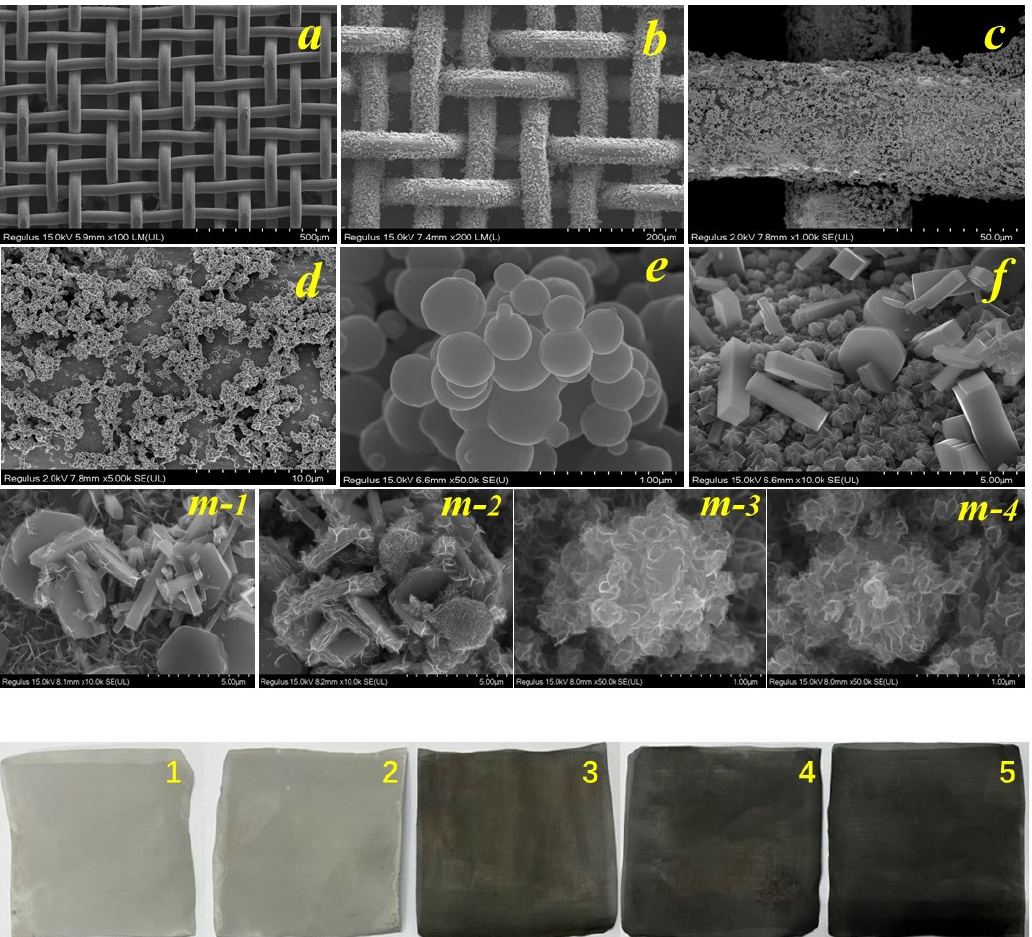
Figure 2. SEM of the samples. TiO 2 electron microscope pictures with different magnifications ( a – e ); as-prepared cubic CaTiO 3 ( f ); figures of different quality MoS 2 deposited on CaTiO 3 surface (m-1-m-4); actual figures of the prepared materials (1–5 of Figure 2 correspond to CTO, m-1, m-2, m-3, and m-4,